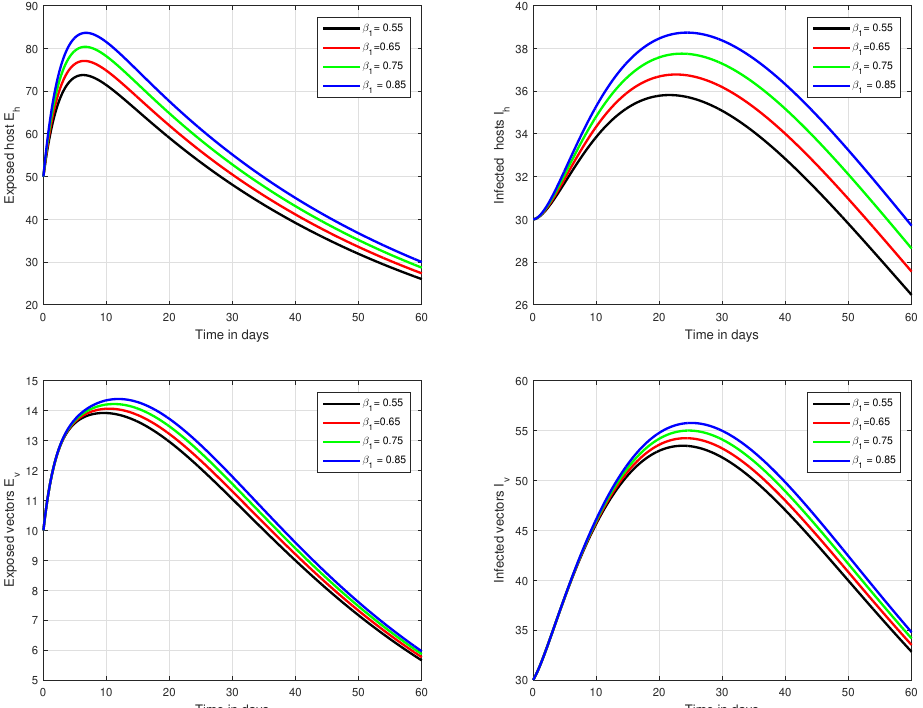
Figure 4. Graphical view analysis of the solution pathways of exposed and infected classes of our fractional system of Zika virus infection with various values of the parameter β 1 , i.e., β 1 = 0.55,0.65,0.75,0.85.